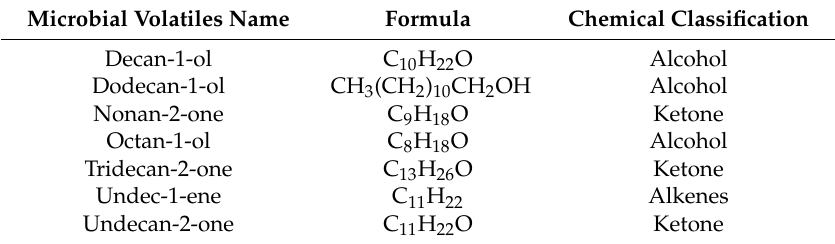
Table 4. Microbial volatile compounds emitted by E. coli